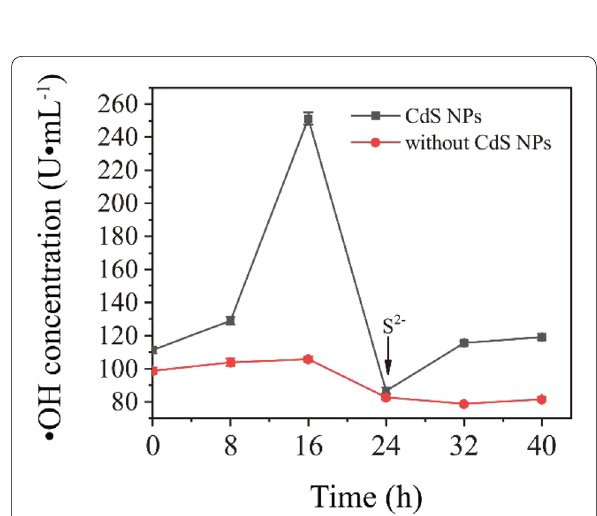
Fig. 11 The effect of adding S 2 − on the content of